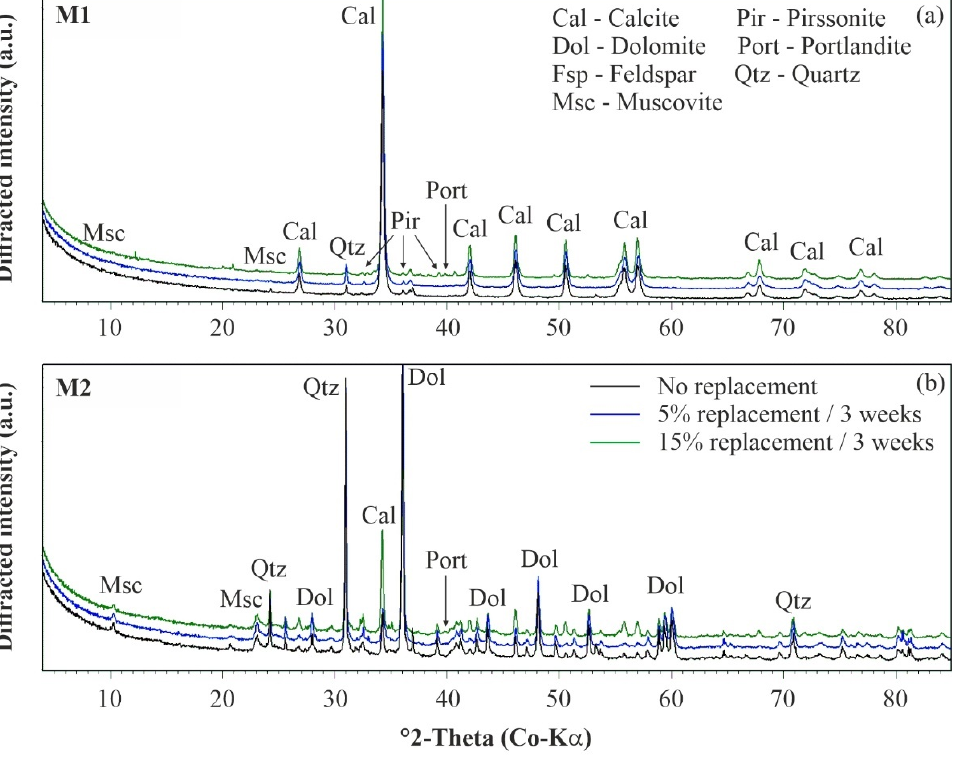
Figure 7. Mineralogy of uncemented and artificially cemented soil specimens: ( a ) M1 and ( b ) M2 . XRD patterns have been shifted vertically for better visibility.